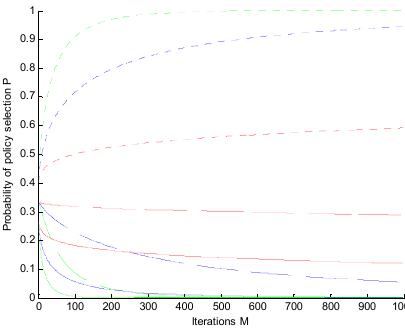
Figure 11. Relation between P and M .